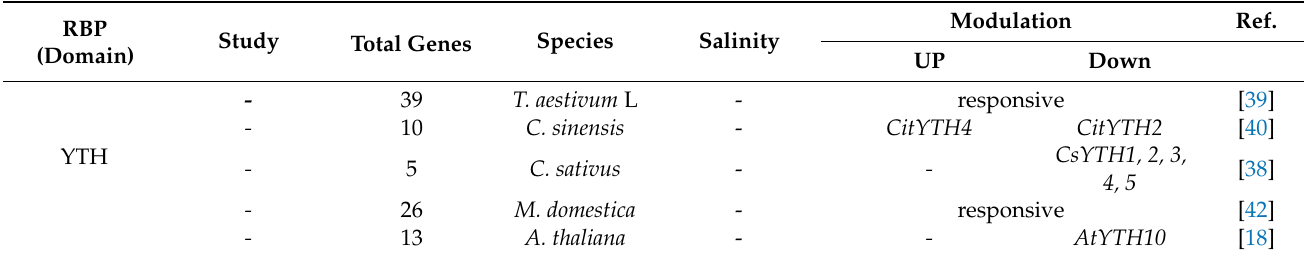
Table 2. Plant RNA binding proteins implicated in high-salinity stress